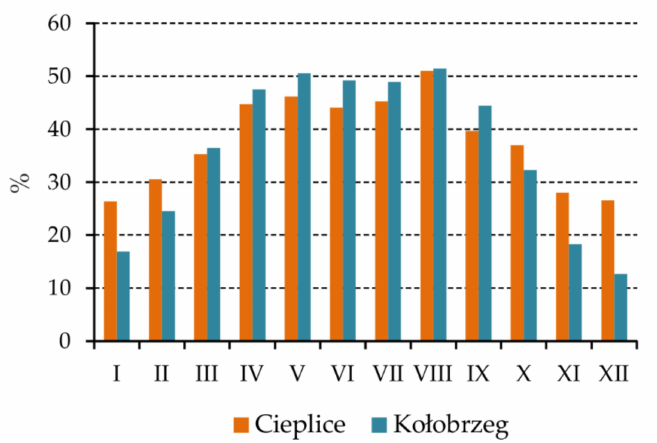
Figure 5. The annual course of relative sunshine duration in Cieplice and Kołobrzeg. Average values for the years 1996–2015.